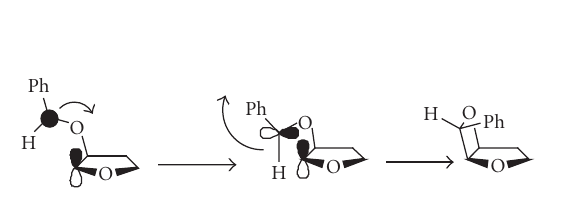
Figure 2: HSOMO and LSOMO of the biradical intermediate N .